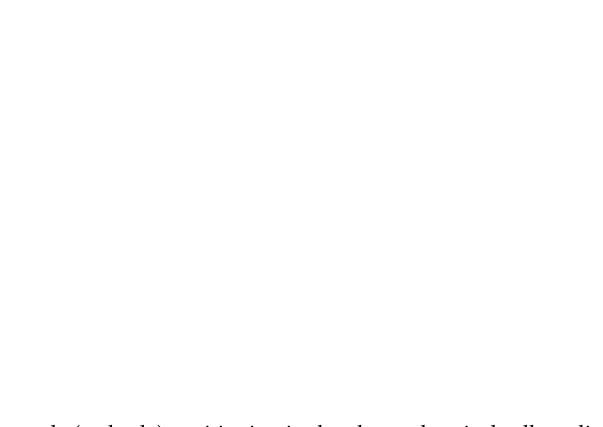
Figure 10. Scheme of the discharge electrode (cathode) positioning in the electrochemical cell ap- plied in [62,64]. Illustration of the active length of the discharge electrode.